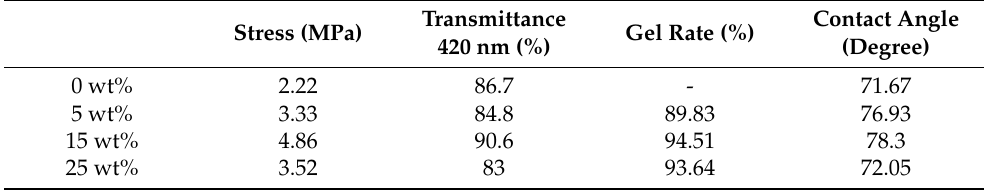
Table 2. Properties of the binder samples.